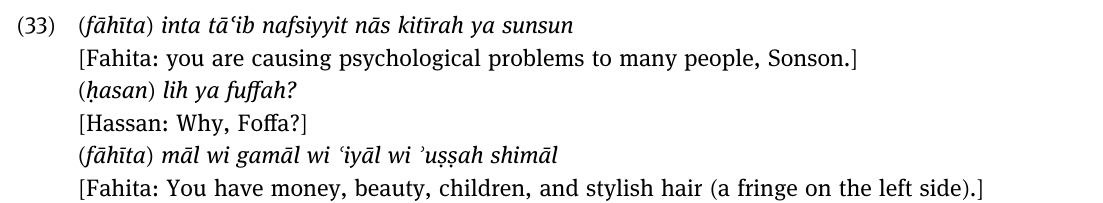
[ Fahita: You have money, beauty, children, and stylish hair ( a fringe on the left side ) . ]